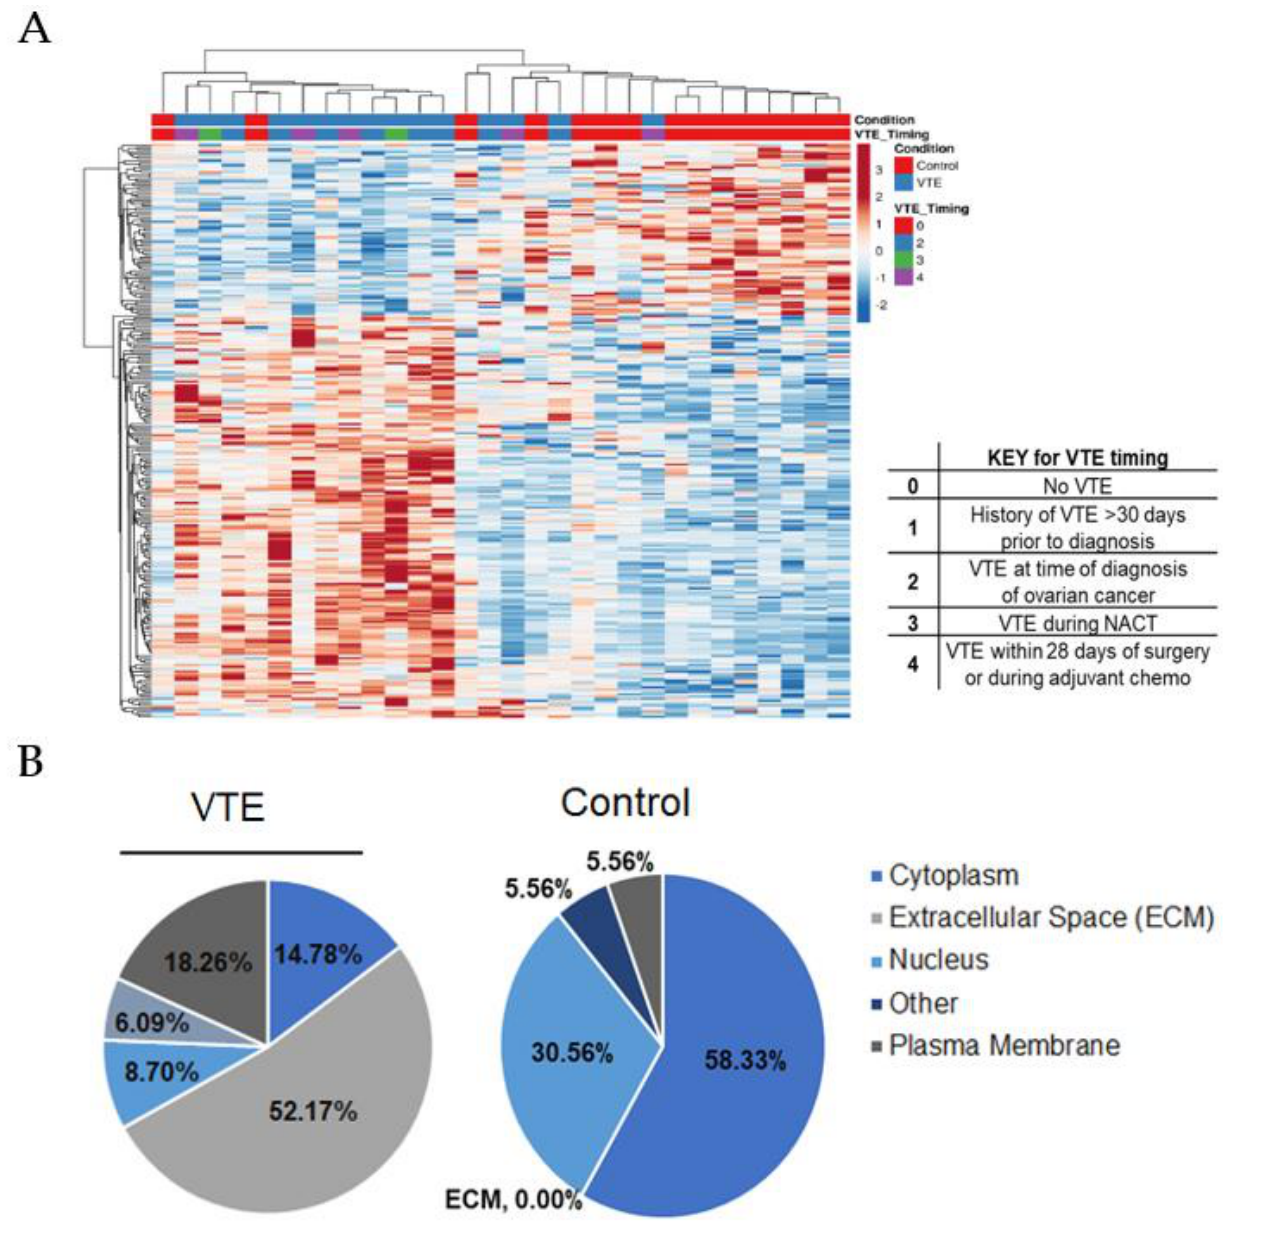
Figure 3. Significantly altered proteins in HGSC tumor tissues between VTE and control groups. ( A ) Supervised hierarchical cluster analysis of 255 significantly altered proteins between VTE and control tumors, including VTE timing metadata. ( B ) Cellular localization of 255 proteins that were significantly altered between VTE and control tumors (LIMMA, p < 0.01).